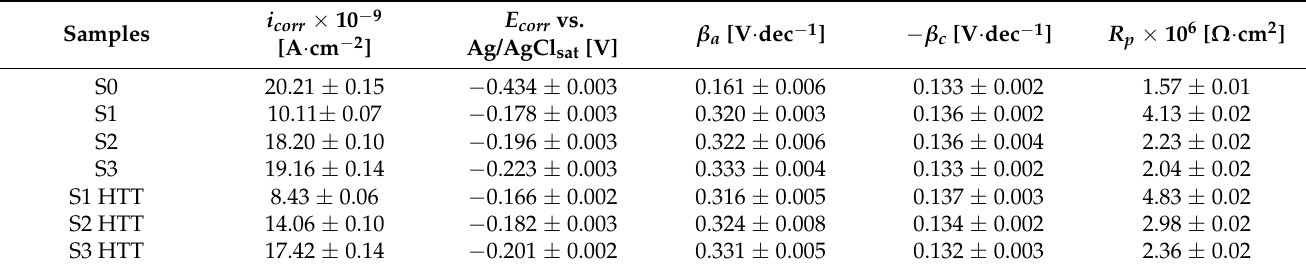
Figure 8. PPT curves were obtained in Hanks’ solution for the following samples: ( a ) S0–S3; ( b ) S0 and S1 HTT–S3 HTT. Table 6. The main electrochemical parameters were obtained by analyzing the PPT curves in Hanks’ solution.